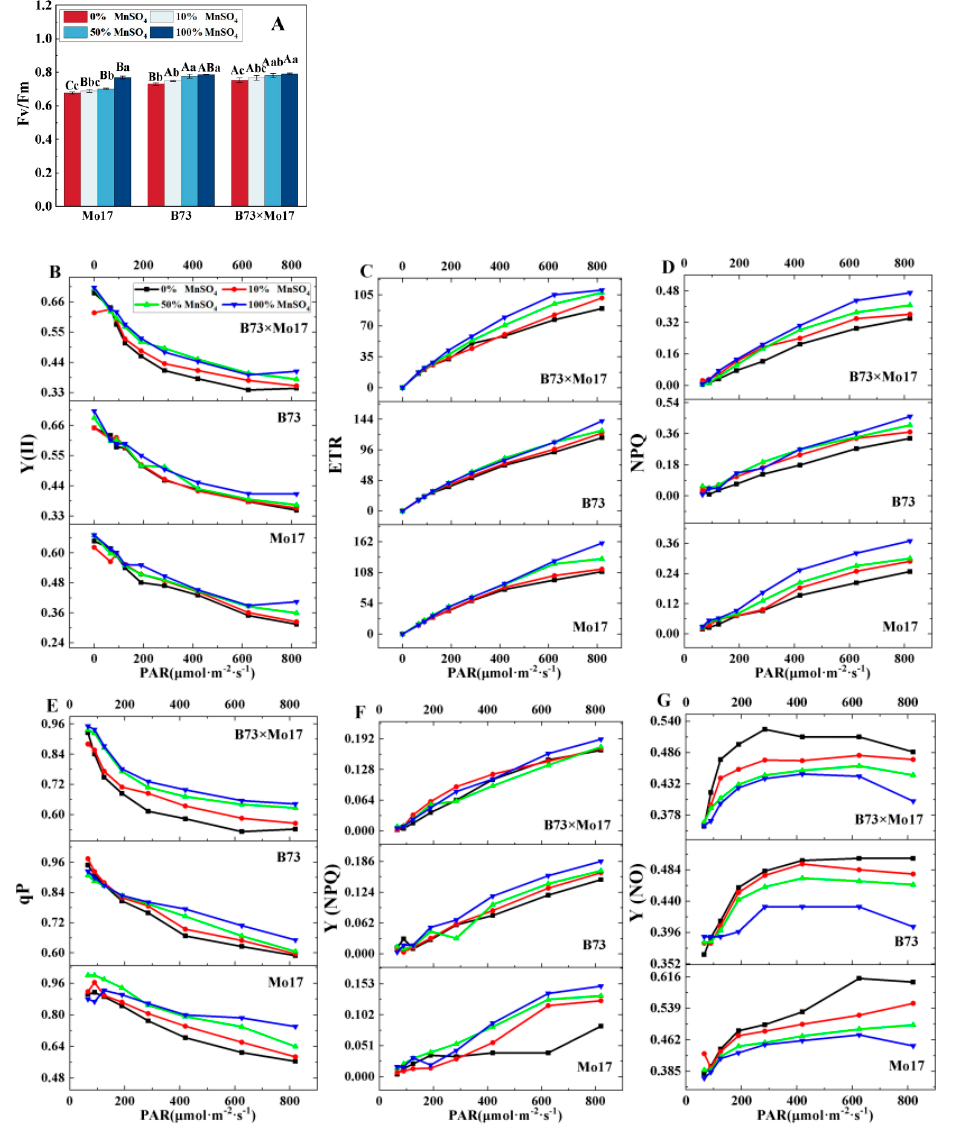
Figure 4. Effect of Mn deficiency on chlorophyll fluorescence parameters of maize seedling leaves. Fv/Fm: maximum photochemical efficiency ( A ), Y(II): photochemical quantum yield of PSII ( B ), ETR: electron transport rate ( C ), NPQ: Non-photochemical fluorescence quenching ( D ), qP: photo- chemical quenching coefficient ( E ), Y(NPQ): quantum yield of non-photochemical fluorescence quenching in light-acclimated samples ( F ), Y(NO) quantum yield of non-photochemical fluoresc- ence quenching in dark-acclimated samples ( G ). According to the LSD test different capital letters: significant difference between varieties ( p < 0.05); different lowercase letters: significant difference between MnSO 4 treatments ( p < 0.05). Data are expressed as the mean of three replicates.